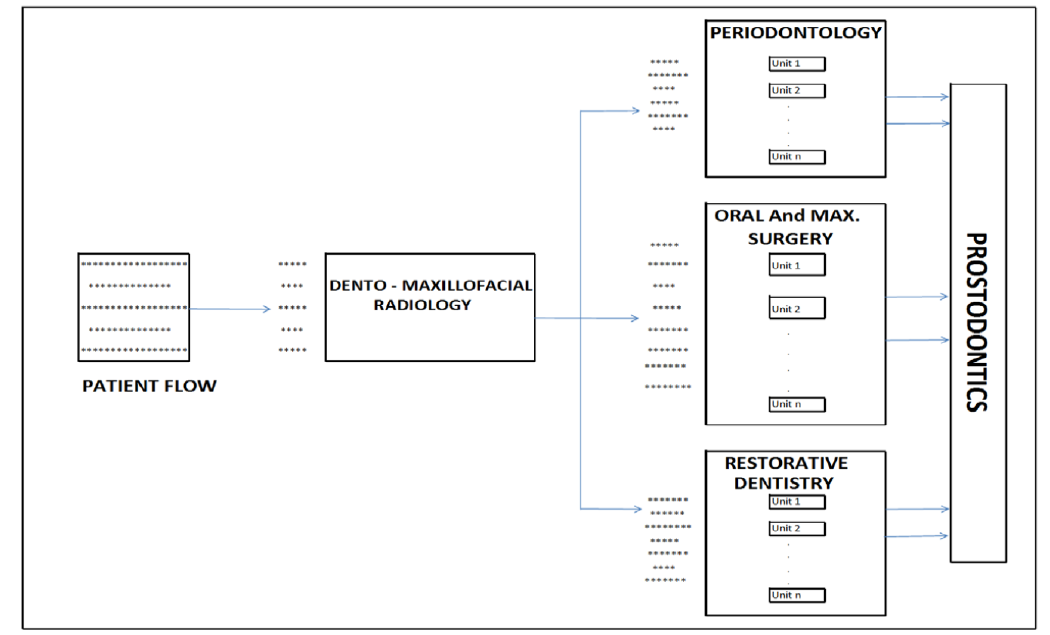
Figure 3. Proposed system for patient treatment route and queue (Tekin & Erol,